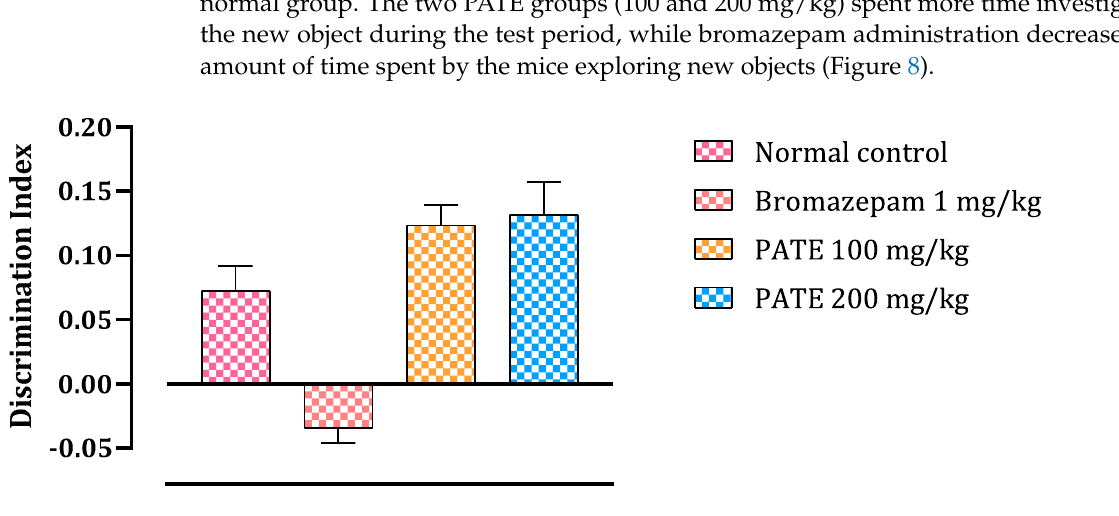
Figure 8. Discrimination index in the NORT. Values are expressed as mean ± SEM.